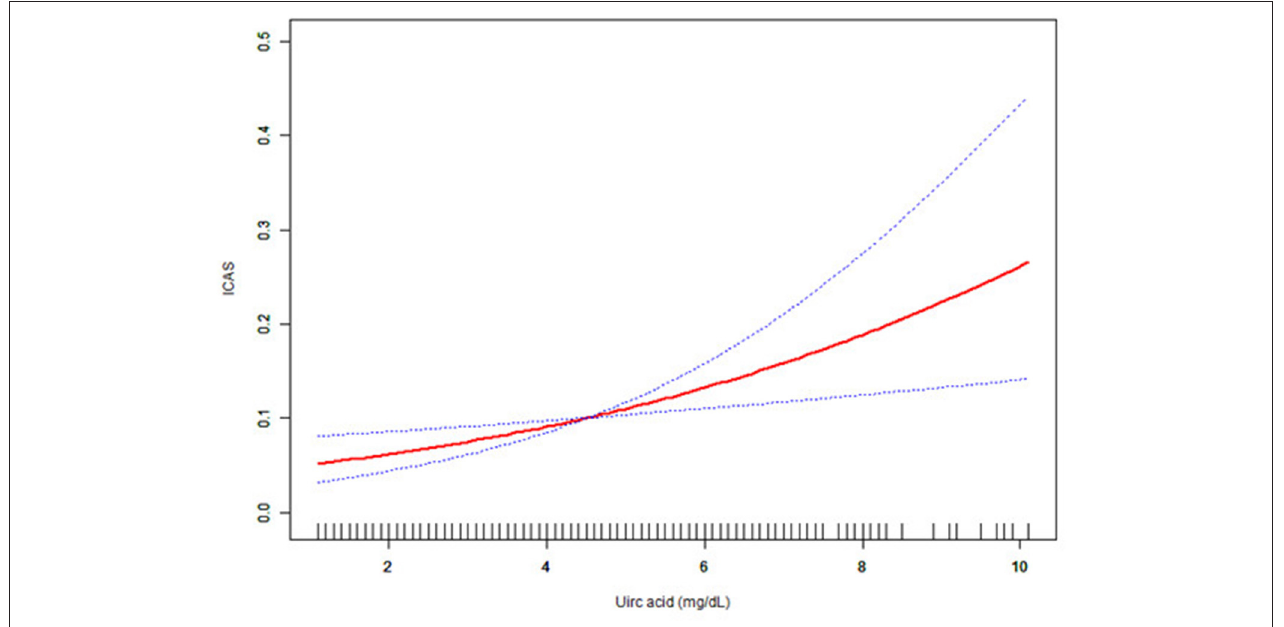
FIGURE 1 | The effect of uric acid on intracranial arterial stenosis (ICAS) in subgroup size forest plot. CAOD, coronary artery occlusive disease.